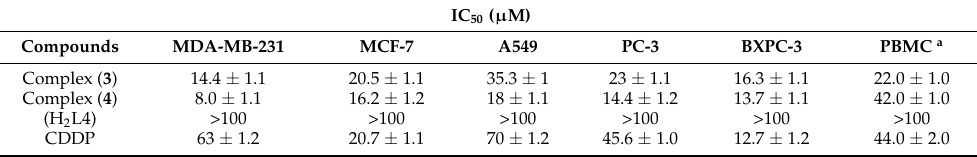
Table 1. Cell cytotoxicity induced by the platinum complexes determined by MTT assay.